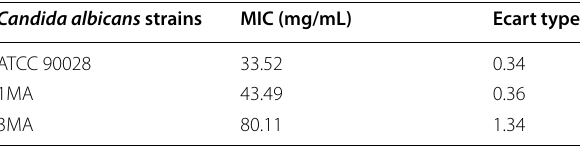
Table 6 MIC of the aqueous extract of Pteleopsis suberosa on the tested strains